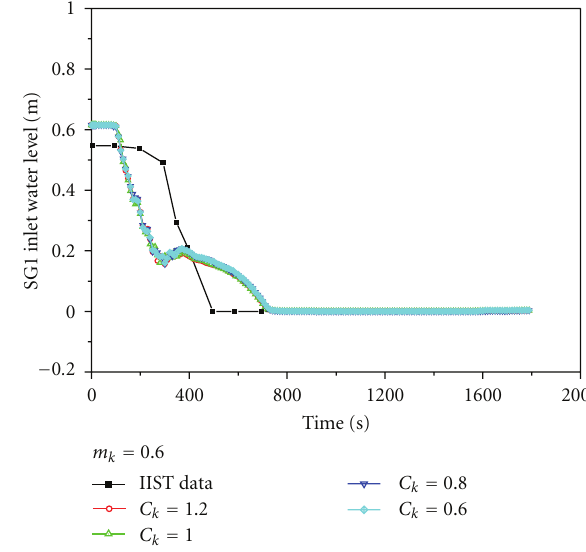
Figure 10: The CCFL sensitivity study of m k for SG1 inlet water level.